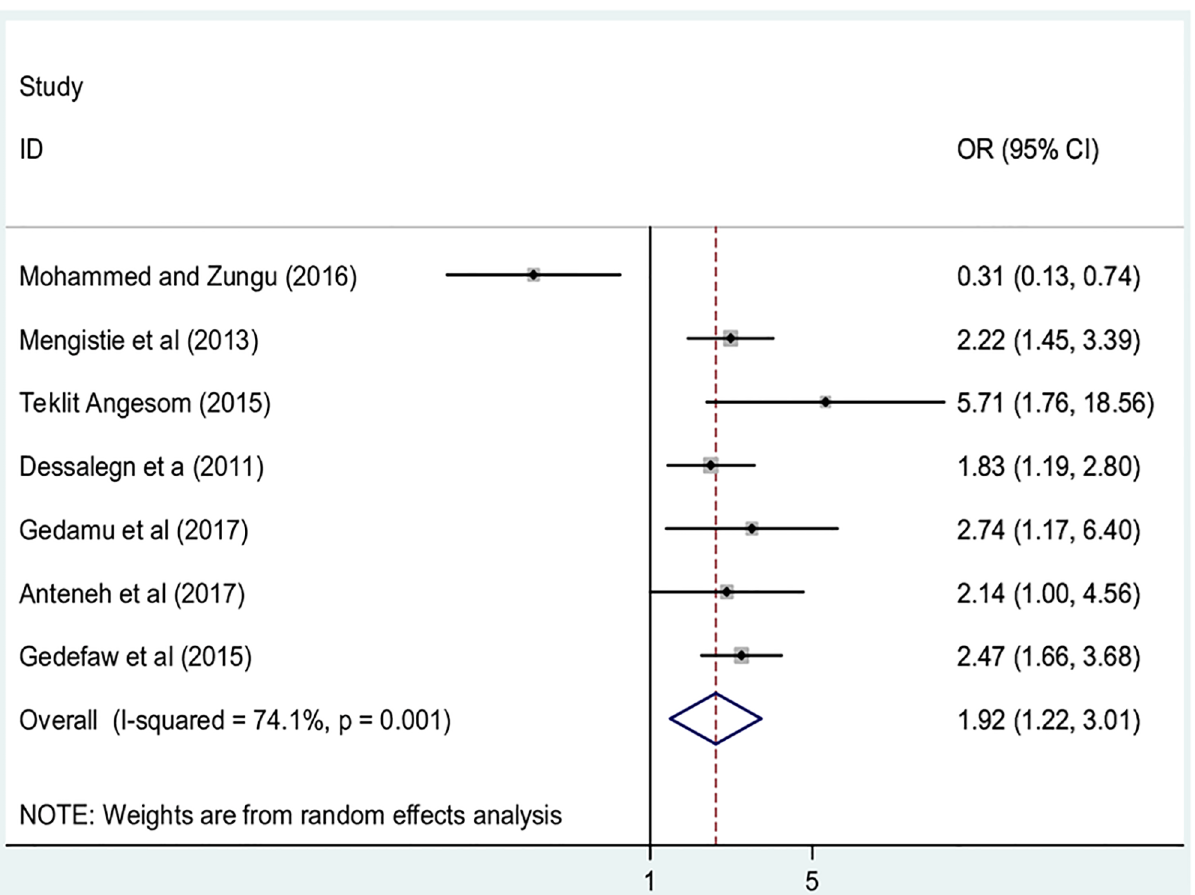
Fig 6. The pooled odds ratio of the association between residence and childhood diarrhea in Ethiopia.